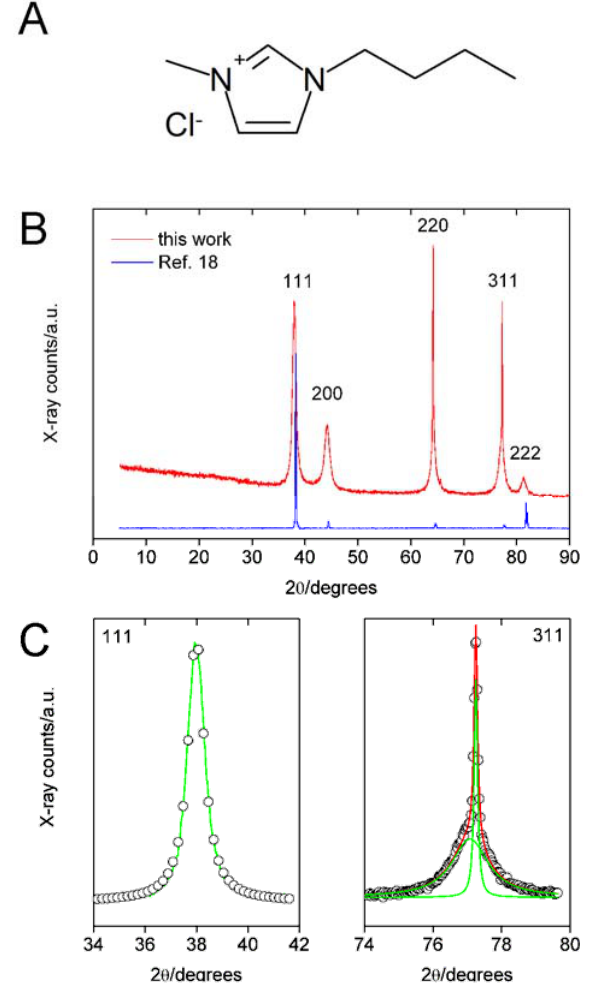
Figure 1. A: Structure of [Bmim]Cl. B: XRD pattern of a sample prepared via injecting a solution 20 mg of cellulose and 20 mg of HAuCl NaBH . The pattern from ref. [18] is displayed for comparison. C: magnified (111) and 4 (311) reflections showing the superposition of two Lorentzians for (311). Symbols are experimental data, green lines are individual Lorentzians, and red line is the